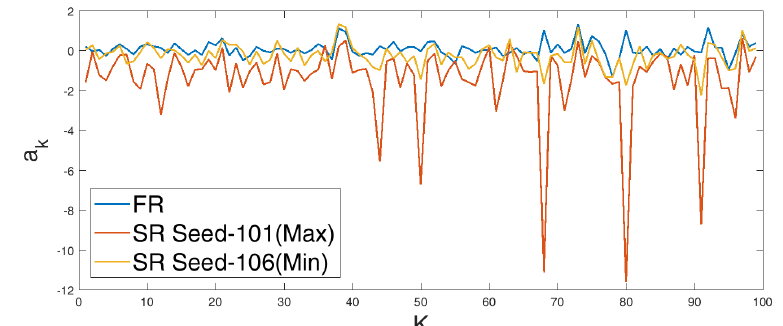
Figure A3. Comparison of the sparse reconstructed (SR) ELM features with the corresponding full data reconstruction (FR) predicted features. The two SR cases correspond to sensor placement with maximum error (seed = 101) and minimum error (seed =